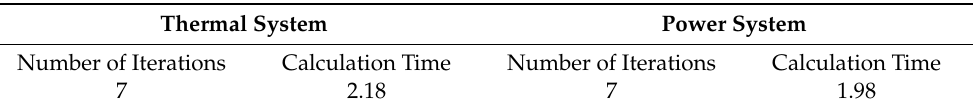
Table 1. The number of iterations and calculation time of affine algorithm for thermal–electric multi-energy complementary distributed energy